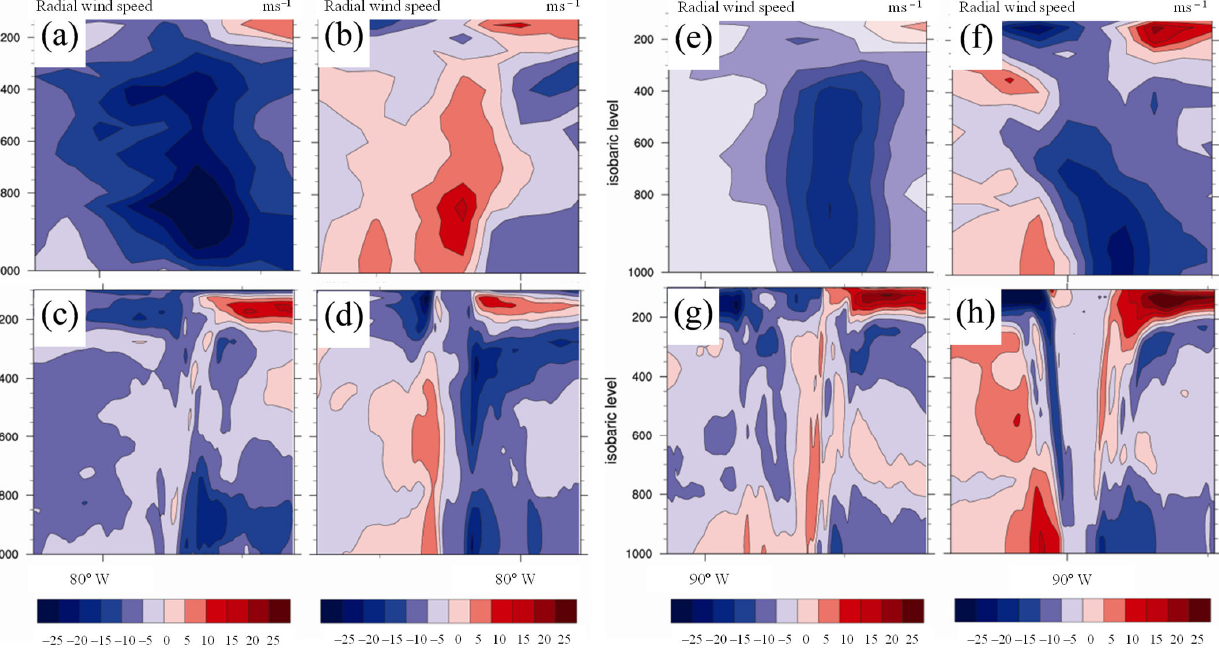
Figure 10. Cross ‐ sections showing the radial wind (m s − 1 ) of the TC according to ( a , c , e , g ) 24 and ( b , d , f , h ) 48 h forecasts taken from the GFS (upper panels) and HRS/HLAPS (lower panels). The left and right panels are for Hurricanes Dennis and Katrina, respectively.